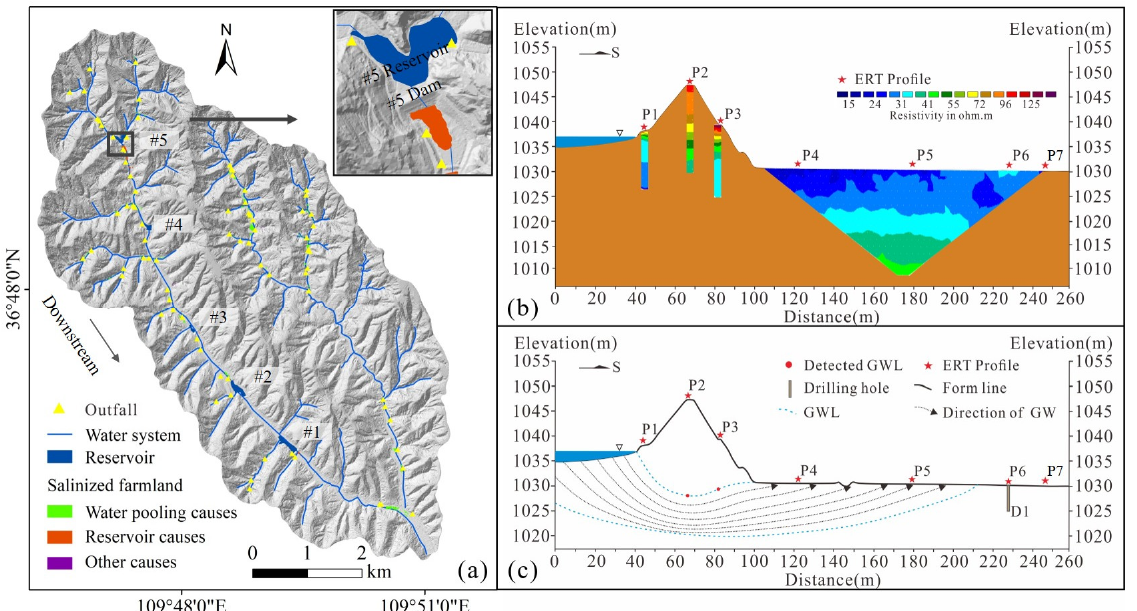
Figure 12. Distribution and causative patterns of salinized arable land. ( a ) Distribution map of land where salt precipitates were observed, and the top right graph shows the salinized arable land downstream of the #5 reservoir and #5 dam in greater detail; ( b ) results for 7 ERT profiles; ( c ) groundwater seepage pattern of the #5 dam; GWL: Groundwater level; GW: groundwater.